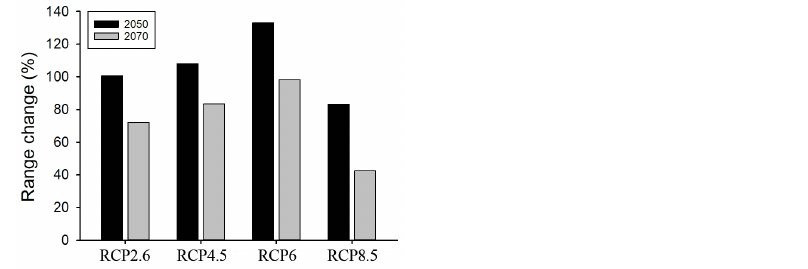
Figure 6. Future distribution of suitable habitats for Paradoxornis heudei . The blue areas are currently known to be suitable habitats and may remain so in the future. The red areas represent newly